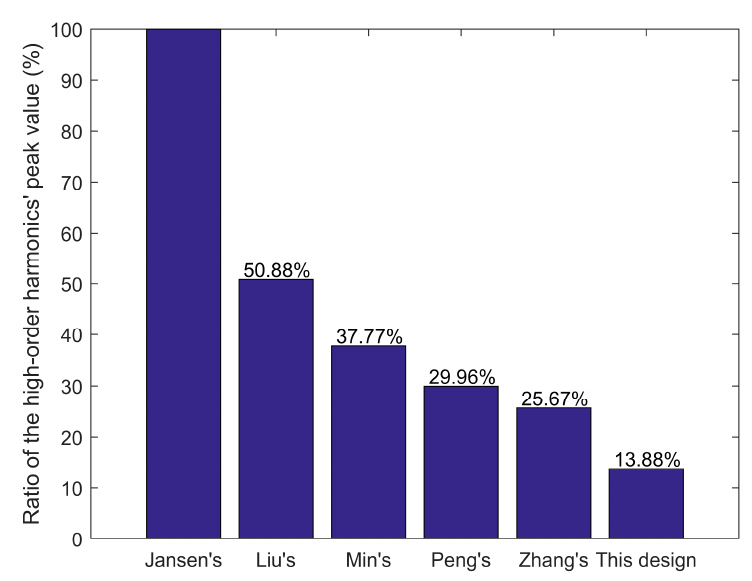
Figure 6. The ratios of high-order harmonics in the m z -direction compared with Jansen’s design.